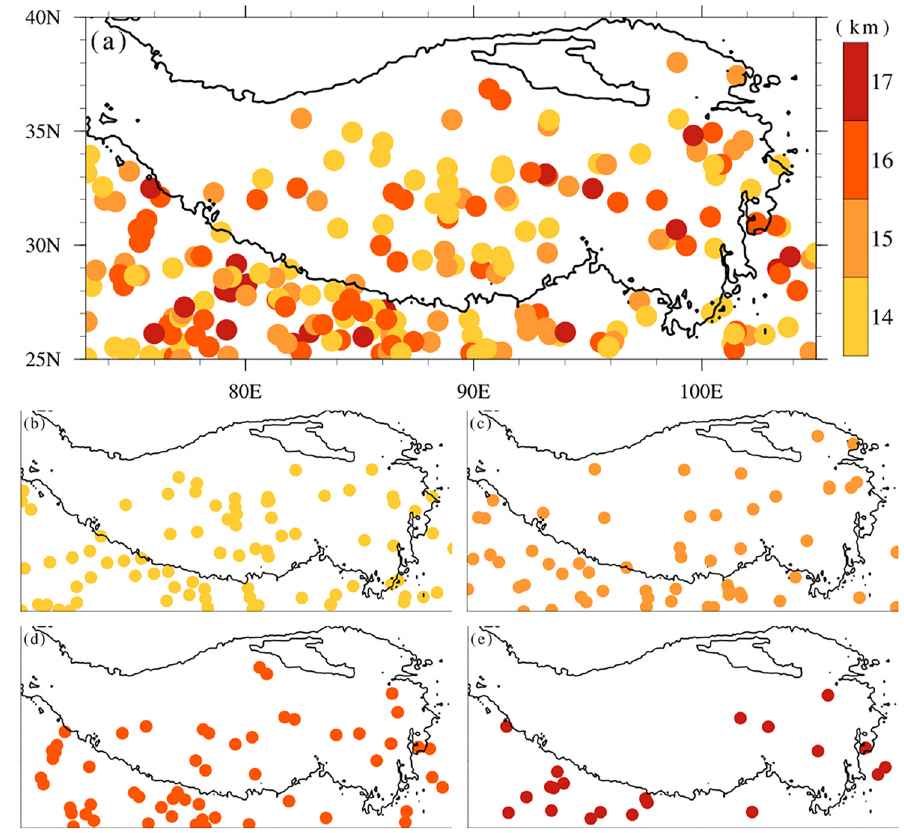
Figure 6. Spatial distribution of DCSs. Each dot is represented a DCS, the color varies with the value of Maxht20, and the darker colors represent stronger DCSs. ( a ) Distribution of all the DCSs. The Maxht20 height is ( b ) >14, ( c ) >15, ( d ) >16, and ( e ) >17 km.